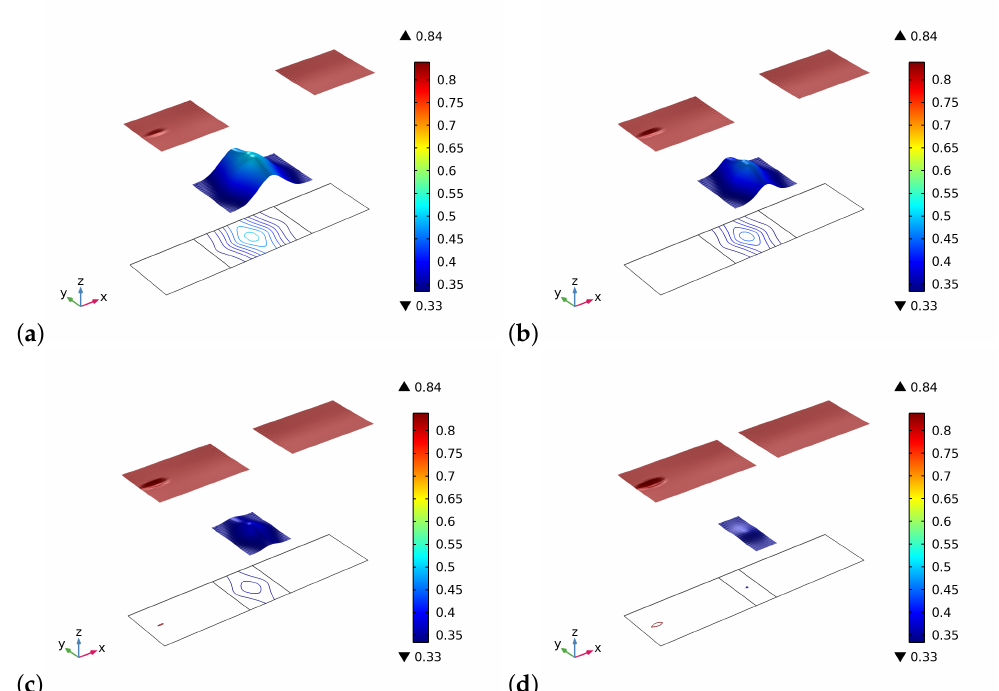
/ ˆ ρ b at the end of the considered period for b